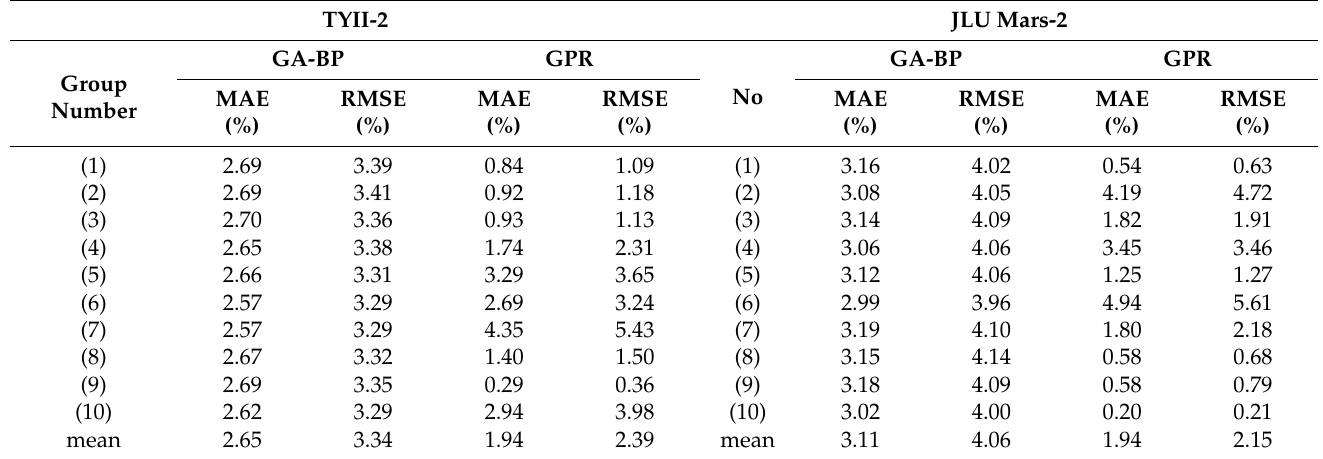
Table 3. Estimation results of GA-BP and GPR on TYII-2 and JLU Mars-2 (slip_ x ). TYII-2 JLU Mars-2